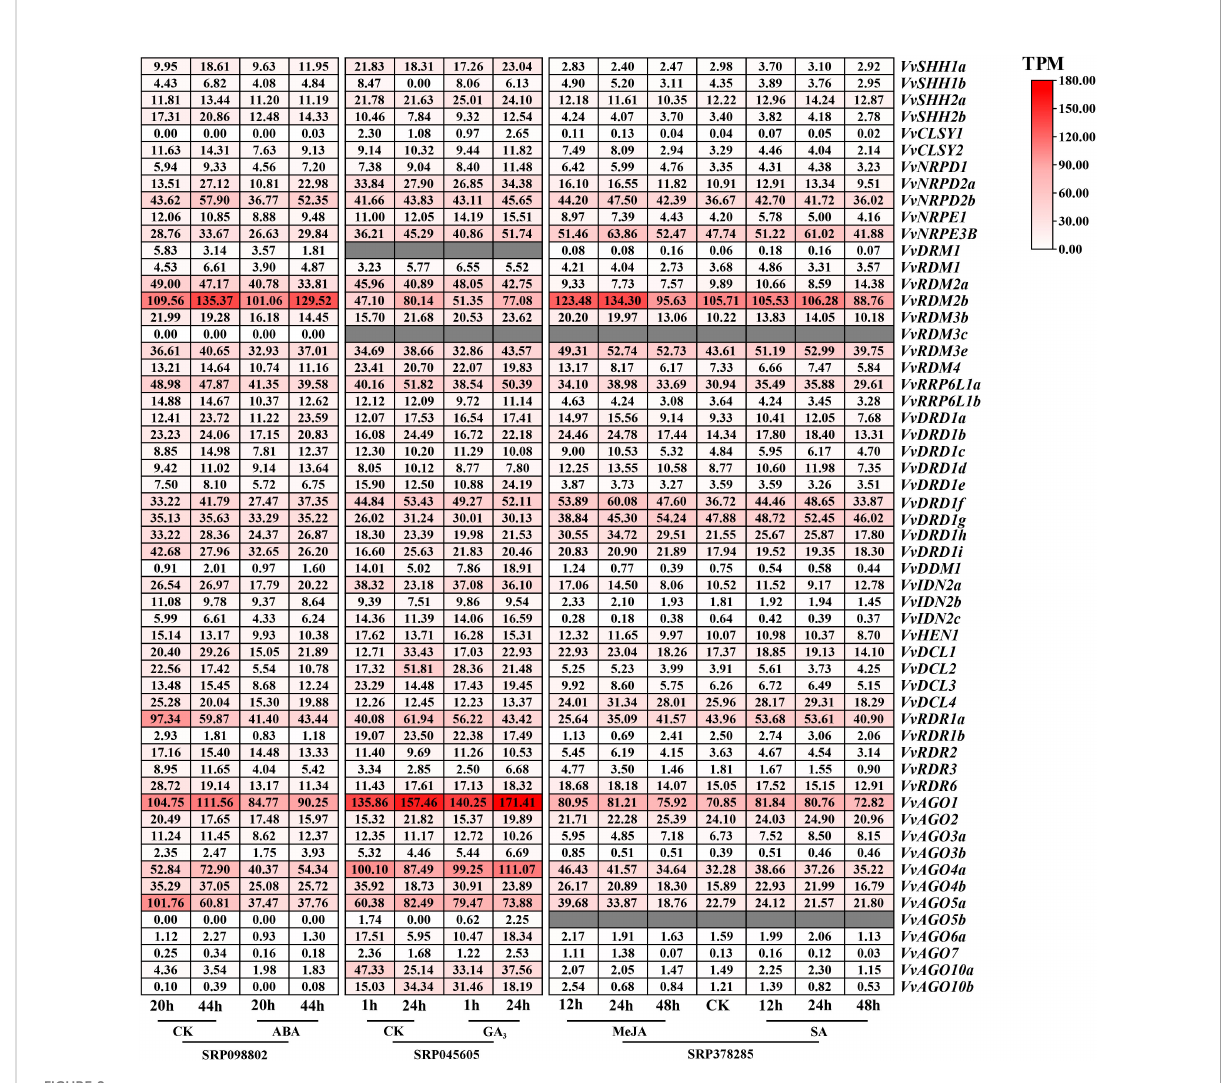
FIGURE 8 Transcriptomic expression of VvRdDM genes following different hormone treatments. Transcriptome data were retrieved from the NCBI SRA datasets (SRP09880, SRP045605 and SRP378285). The white and red color scale denotes low and high expression levels, respectively. No gene expression is denoted with grey color. Numbers denote TPM of VvRdDMs